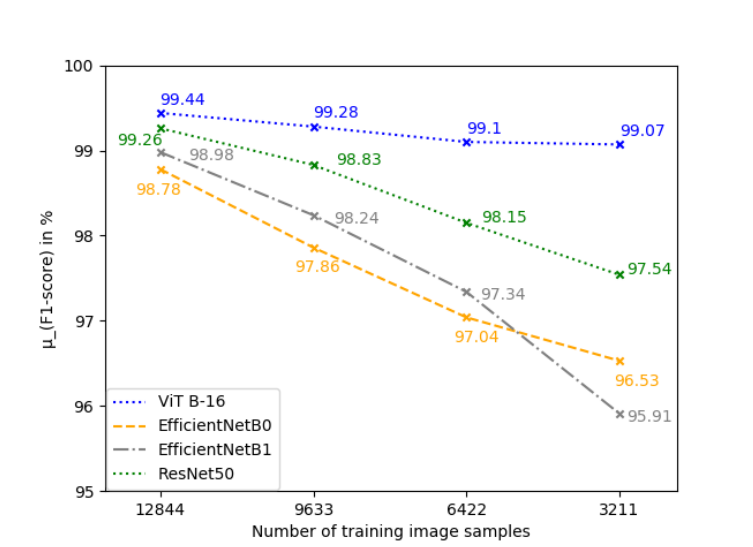
Figure 12. Comparison between ViT B-16, EfficientNet B0, EfficientNet B1 and ResNet50 on their respective performance with different number of training images.